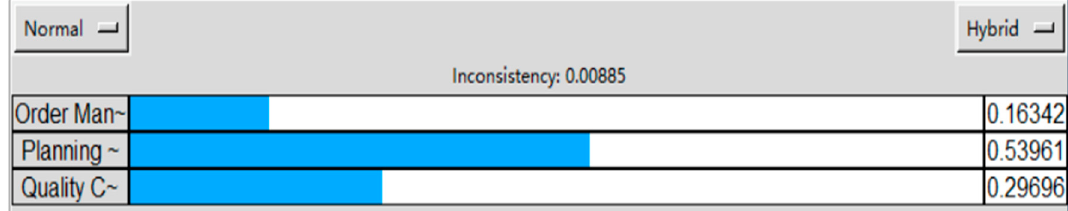
Figure 6. Index consistency test results.